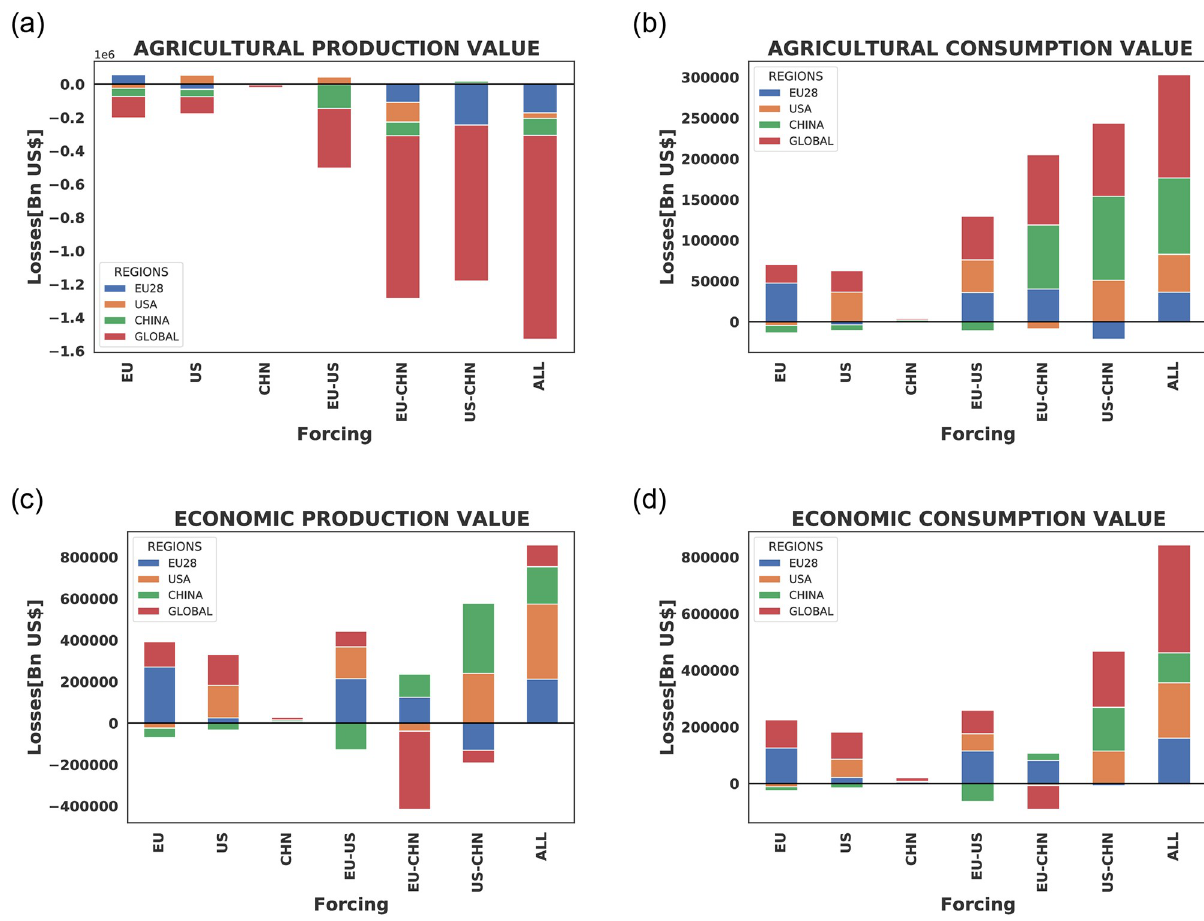
Fig 6. A comparative analysis of the various forcing scenarios on the mean agricultural production value losses 6a and consumption values losses 6b. Economic production value and consumption value losses are presented in 6c and in 6d respectively.